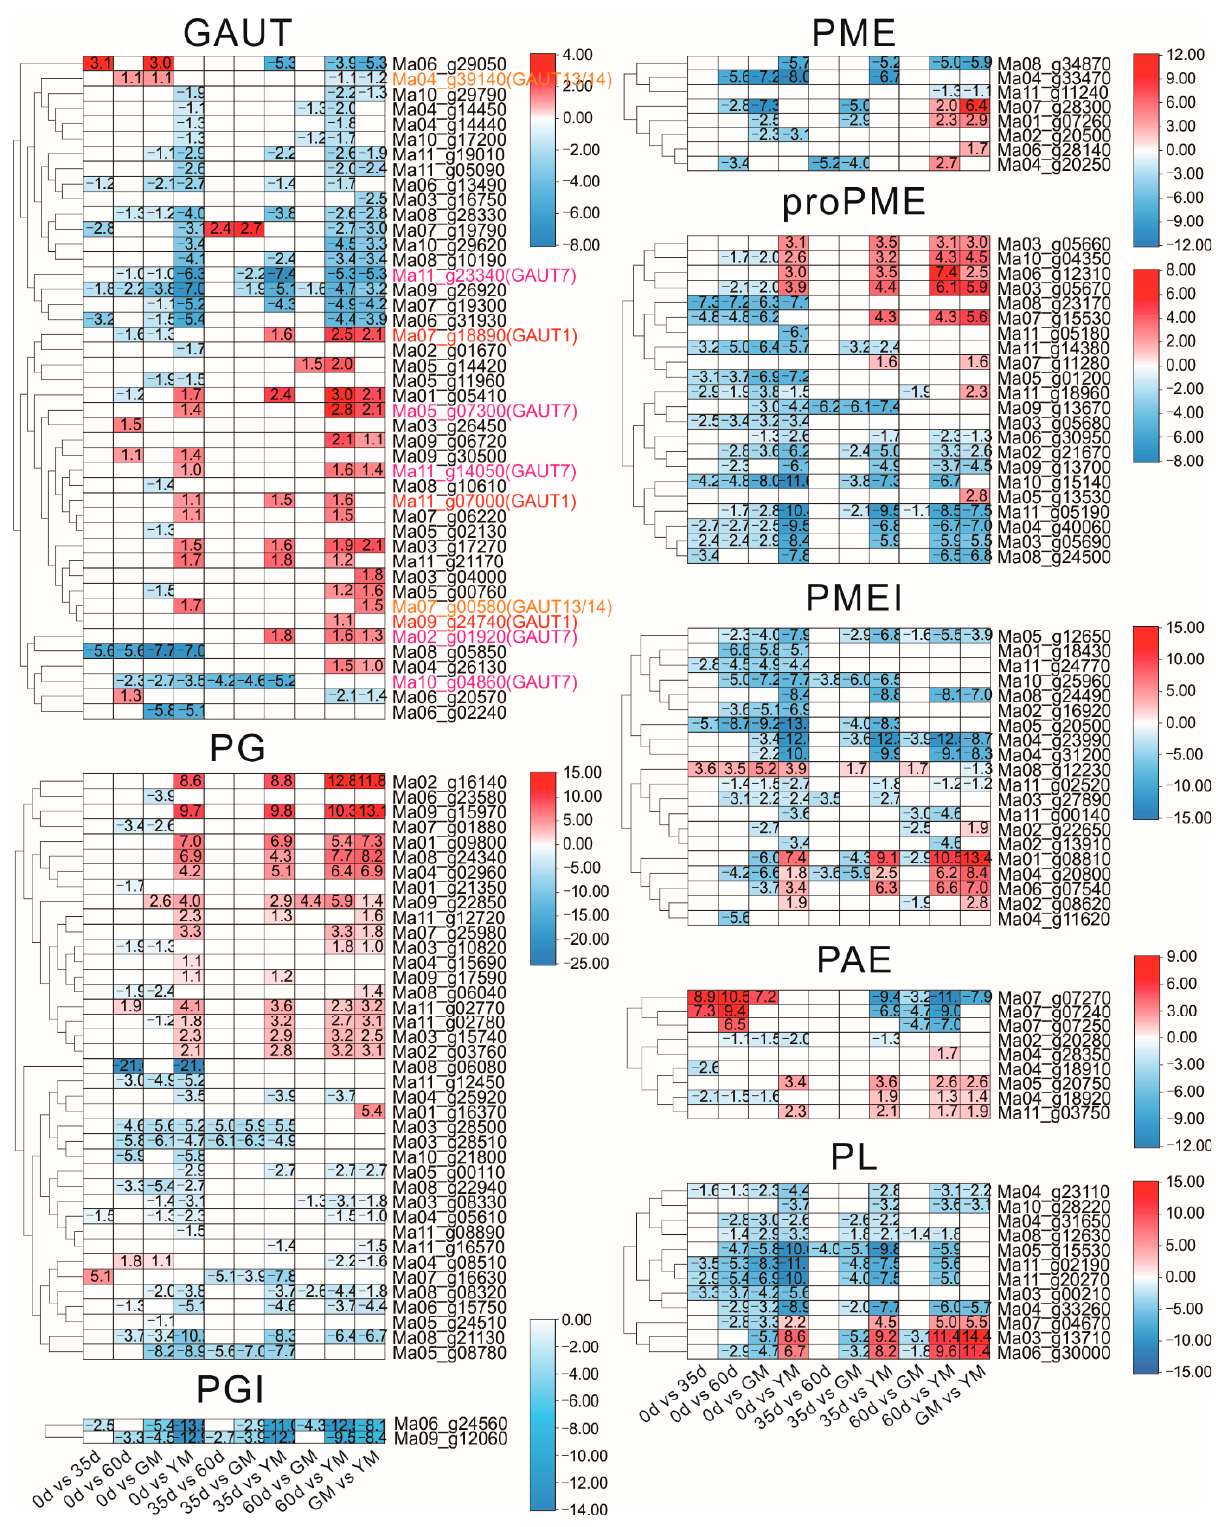
Figure 3. Differentially expressed homogalacturonan-modifying genes in banana ( Musa spp. AAA) peel during fruit development and ripening. 0 d: fruits just emerging from the bunch; 35 d: 35 day-old fruits; 60 d: 60 day-old fruits; GM: green matured fruits (at harvest, 85 day-old fruits); YM: yellow matured fruits (6 d after ethylene treatment). GAUT: alpha-1,4-galacturonosyltransferase; PAE: pectin acetylesterases; PG: polygalacturonase; PGI: polygalacturonase inhibitor; PME: pectin methyl esterase; PMEI: pectin methyl esterase inhibitor; RNA-Seq: RNA sequencing. Heatmaps are gener- ated from TBtools software with red and blue colors representing upregulated and downregulated,